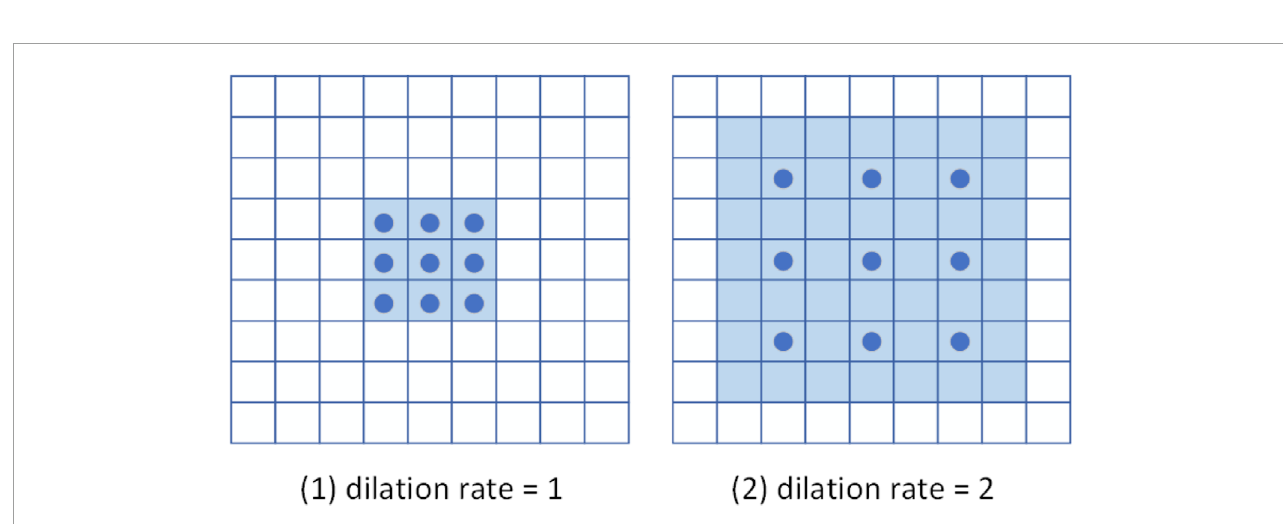
FIGURE 2 Schematic diagram of dilated convolution. The dark blue points represent the convolution kernel, and the light blue area is the receptive field.